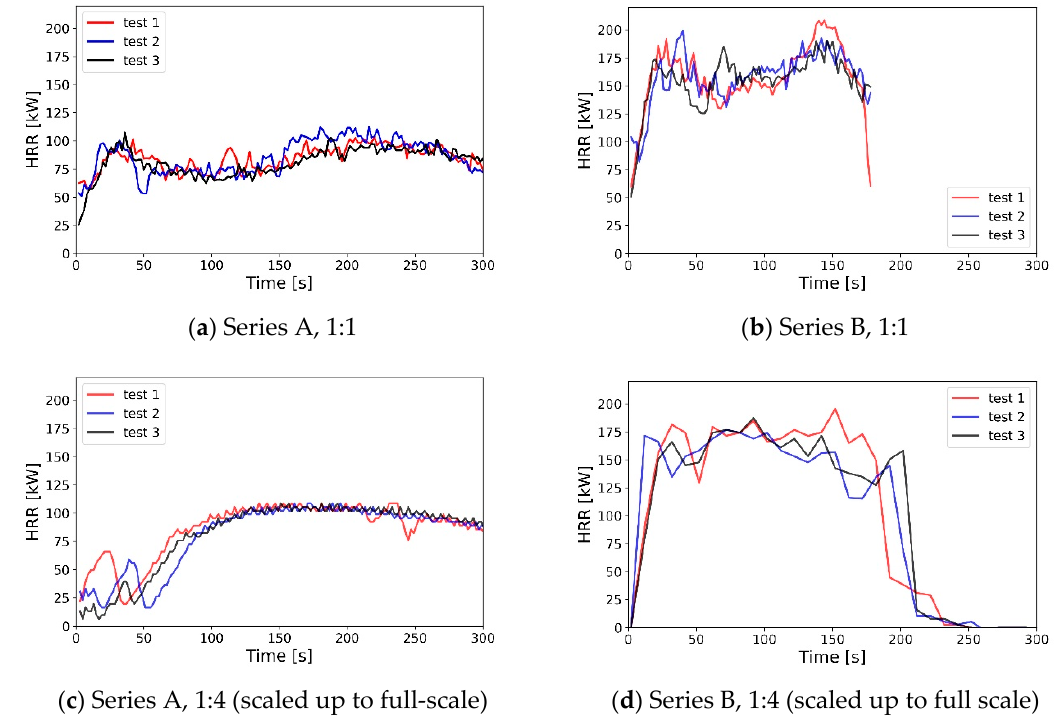
Figure 12. Heat Release Rate (HRR) measurements in the performed experiments—moving averages (5 s averaging time) calculated from mass loss measurements. Values measured in reduced-scale were scaled up based on Equations (5) and (6).